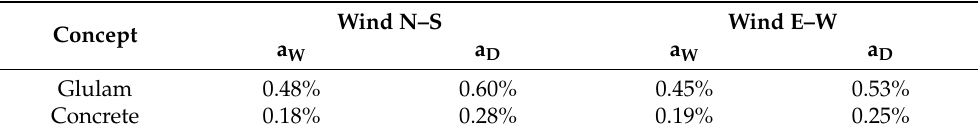
Figure 7. Total horizontal deflections (( a ) N–S direction and ( c ) E–W direction) and interstory drifts (( b ) N–S direction ( d ) E–W direction) associated with wind forces. Accelerations at the roof for both principal directions for the two concepts are pre- sented in Table 7. Table 7. Across- (a W ) and along-wind (a D ) accelerations at the top of the building under worst- in-10-years wind loads for both principal directions. Accelerations are expressed as a function of gravitational acceleration, g (9.81 m/s 2